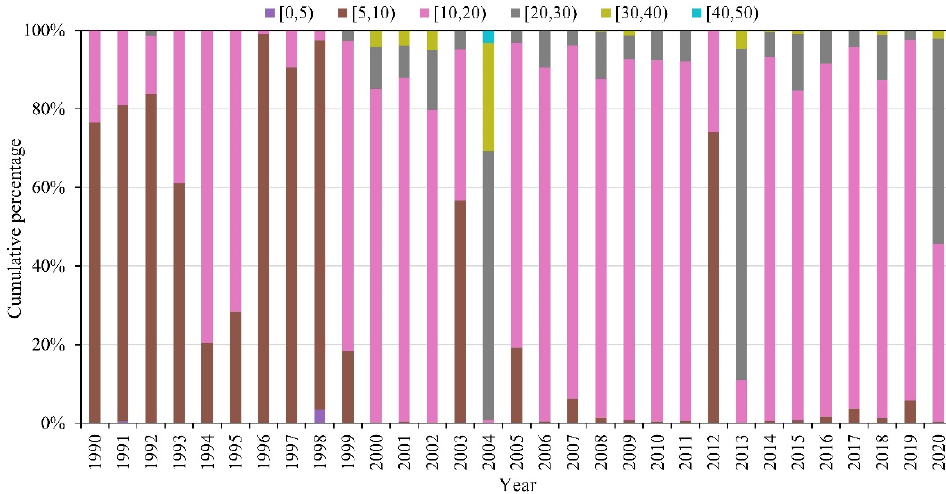
Figure 8. Cumulative percentage of Landsat pixels with the good-quality observations of [0,5), [5,10), [10,20), [20,30), [30,40), and [40,50), respectively, in Zhengzhou City during 1990–2020.